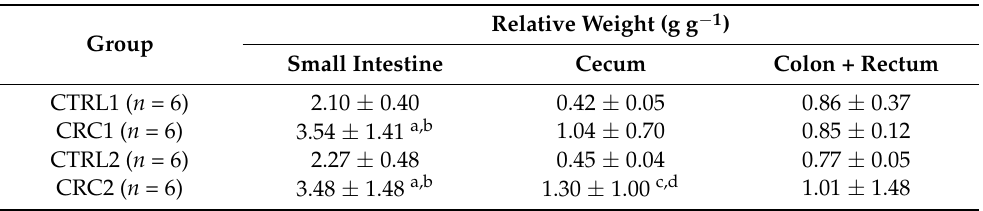
Table 1. Small intestine, cecum, and colon + rectum relative weight in all groups. Data are presented as mean ±